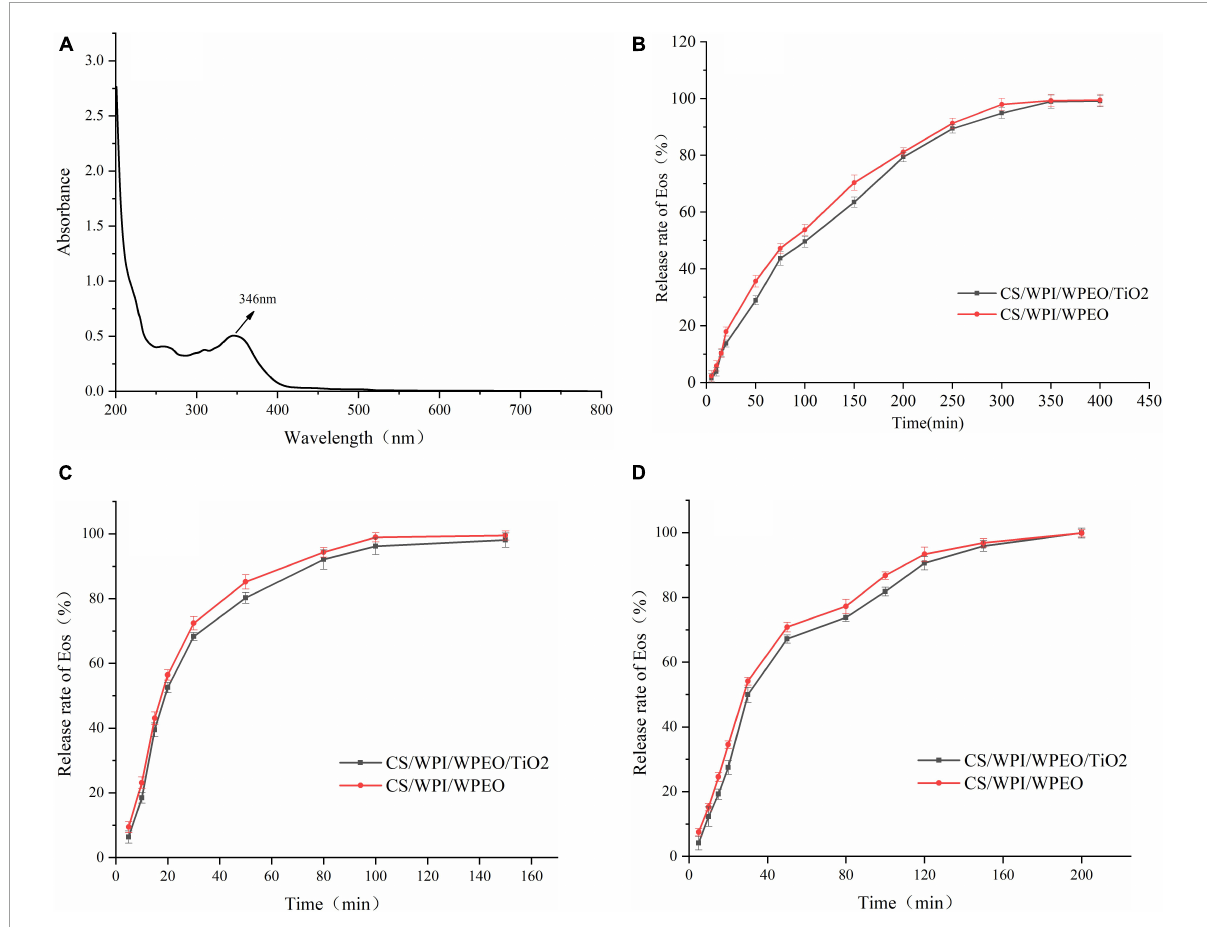
FIGURE6 Full band scanning image of WPEO (A) . Release of WPEO from CS/WPI/WPEO and CS/WPI/WPEO/TiO 2 films in 95% ethanol (B) , 50% ethanol (C) , and distilled water (D)